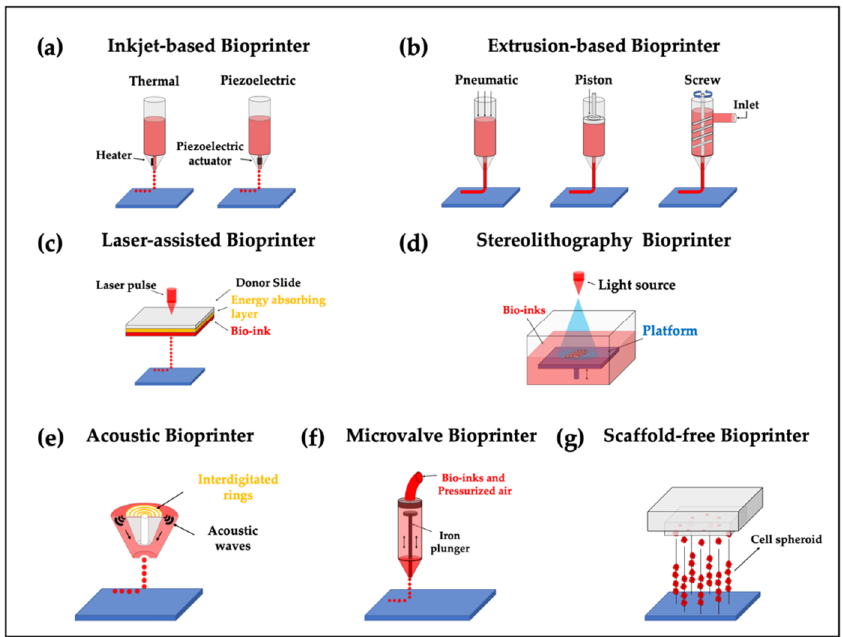
Figure 2. Different types of 3D bioprinters. ( a ) Inkjet- and ( b ) extrusion-based bioprinters were reproduced with permission from [17]; Copyright 2013 John Wiley and Sons. ( c ) laser-assisted bioprinter was reproduced from [18]; ( d ) stereolithography-based bioprinter was reproduced from [19]; ( e ) acoustic and ( f ) microvalve bioprinters were reproduced permission from [20]. Copyright